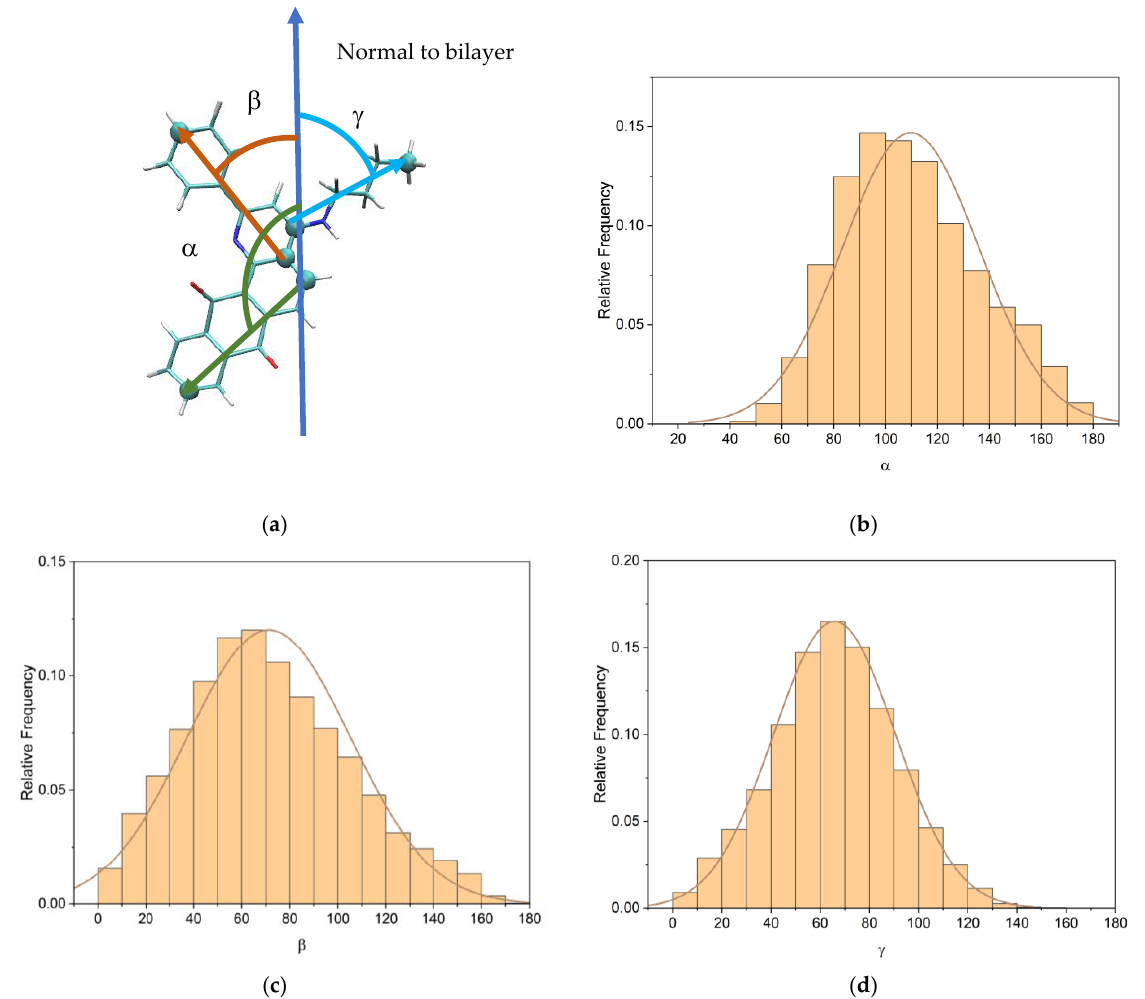
Figure 8. ( a ) Angles selections; ( b ) distribution of the angle between the bilayer normal and the tricyclic part vector of Q1; ( c ) phenyl part vector of Q1; and ( d ) aliphatic part vector of Q1. To estimate the rate of membrane insertion of the anthraquinone, we used the proto- col described in [2,61]. The equilibrium constant of the insertion could be obtained from the following equation: 𝐾 𝑚𝑒𝑚 𝐷 + 𝑀 ↔ 𝐷𝑀 where D is the drug, M is the membrane, DM is the drug bound to the membrane, K m em is the equilibrium constant of reaction: 𝐾 𝑚𝑒𝑚 = 𝑘 𝑖𝑛 𝑘 𝑜𝑢𝑡 where k in is the rate constant of the drug insertion into the membrane, k out is the rate con- stant of the drug release from the membrane. The association constant k in for a ligand in the box, to reach the absorbing surface, is inversely related to the average mean first-pas- sage time for the ligand to hit the surface [2,61]: 𝑘 𝑖𝑛 = 𝐴𝐿 𝑧 < 𝑊 >